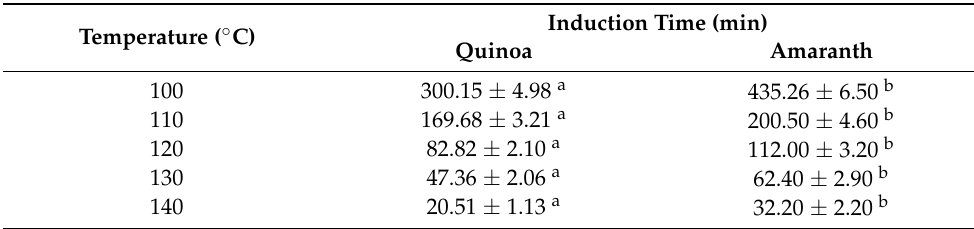
Table 3. PDSC induction time (min.) in the temperature range 100–140 ◦ C of oils extracted from quinoa and amaranth